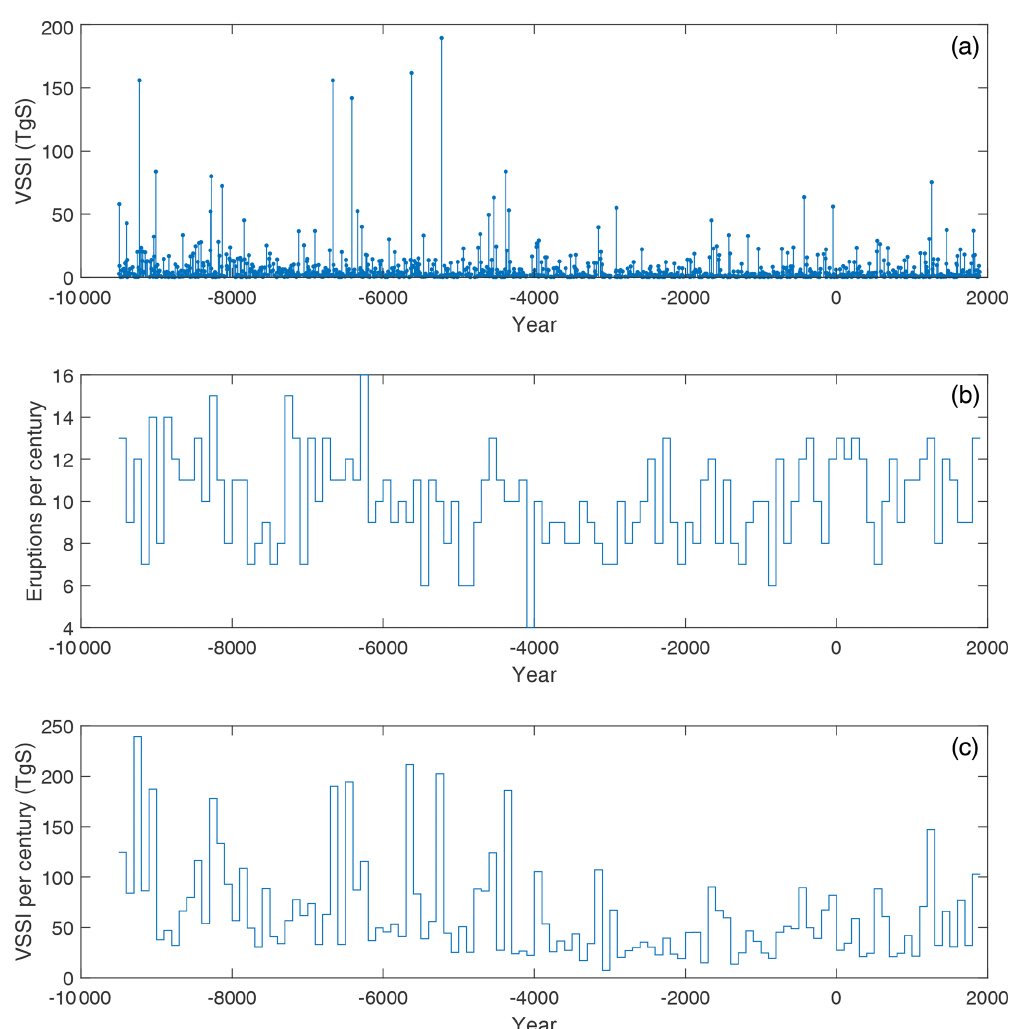
Figure 7. Holocene volcanic stratospheric sulfur injection (VSSI) from explosive eruptions: panel (a) shows the reconstructed VSSI for single eruptions over the Holocene, panel (b) shows the number of eruptions per century and panel (c) shows the total VSSI per century. A version of this figure with VSSI shown separately for the three major source regions – NHET (30–90 ◦ N), SHET (30–90 ◦ S) and tropical (30 ◦ N–30 ◦ S) eruptions – is provided in the Supplement (Fig.